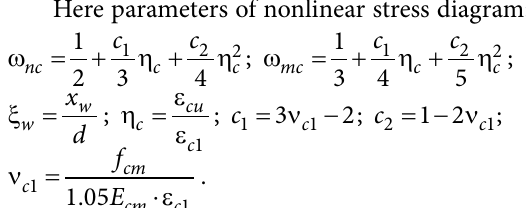
– acting bending moment and There: M and h cr a maximum crack depth. α – reinforcement and con- crete modulus of elasticity ratio and it could be de- scribed as a corrective function (Jokūbaitis et al. 2013); * I – estimated moment of inertia of rectangular cross- 1 section on the crack zone; t – equivalent cross-section height of tensile reinforcement. Calculated reinforcement stress shows the condi- tion of the building’s in exploitation flexed reinforced concrete structure, so we can judge whether further exploitation can be operated, or we can increase the load, or it is in a critical condition.